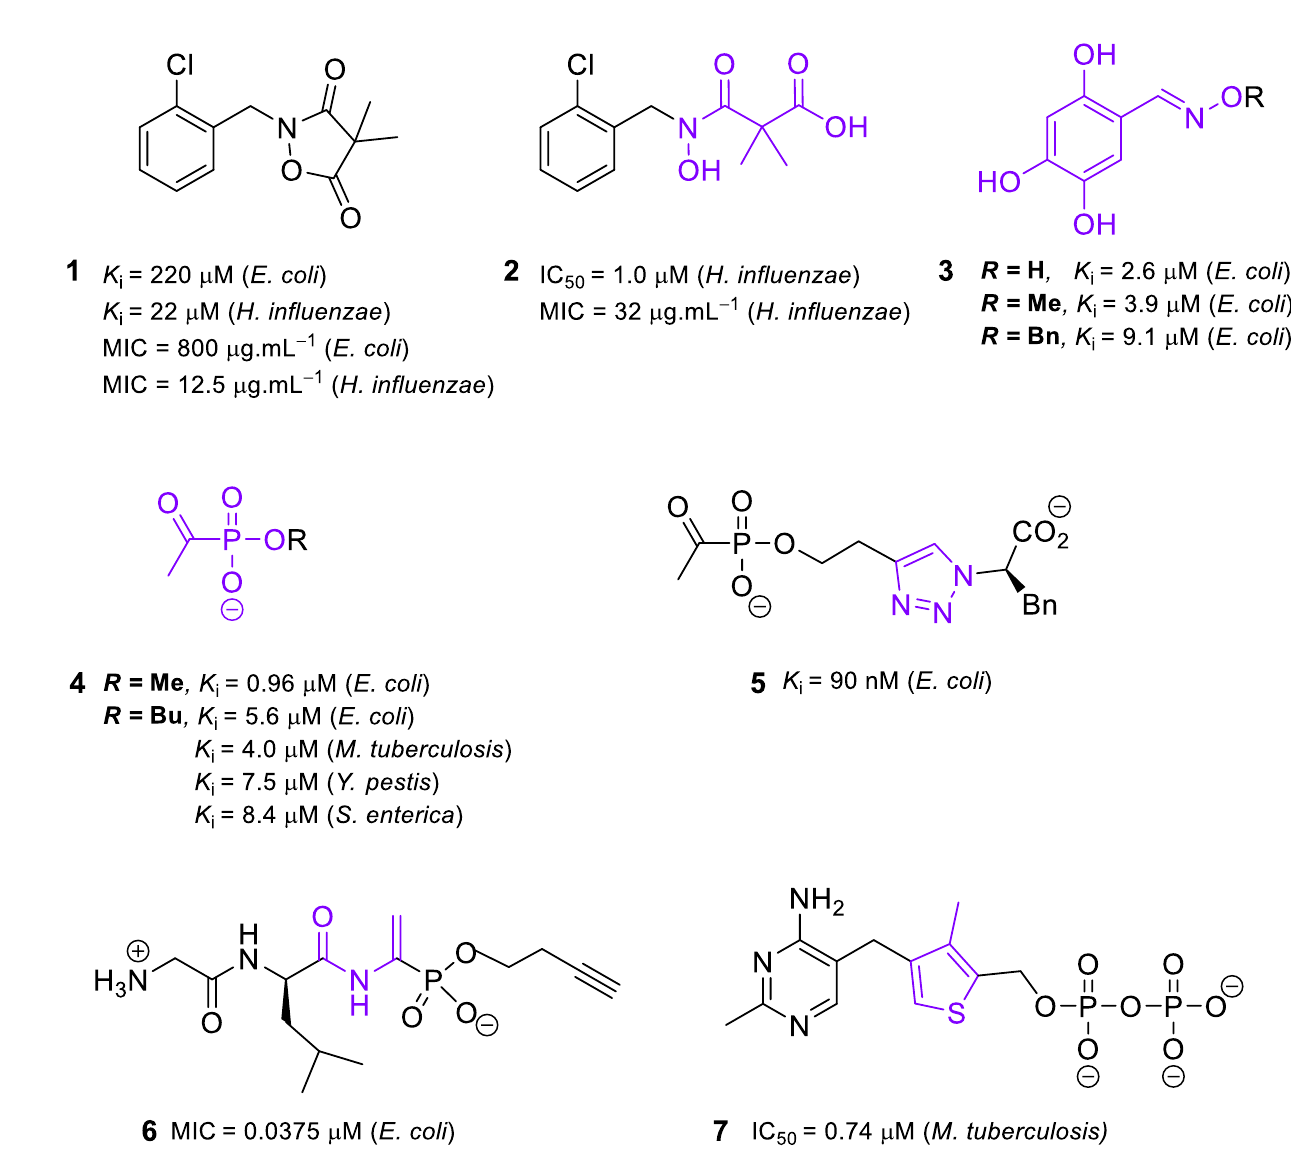
Figure 1. Representative inhibitors of DXS. IC 50 : half maximal inhibitory concentration; MIC: minimum inhibitory concentration; K i : inhibitory constant.